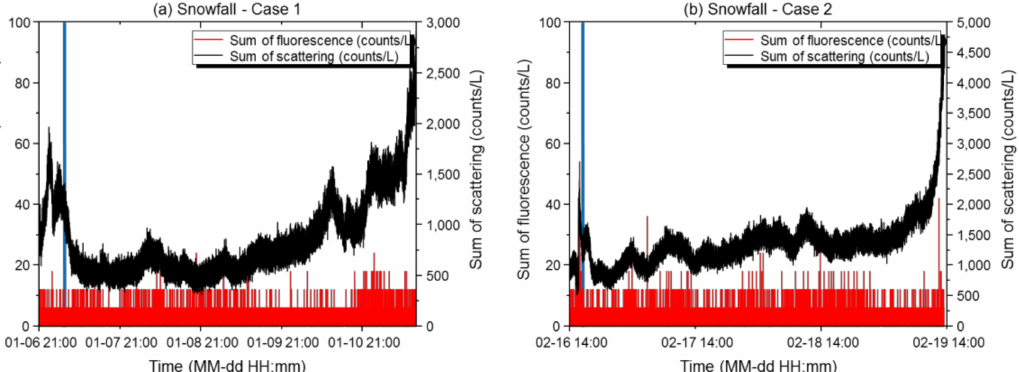
Figure 5. Results of scattered light and fluorescence measurements of the biological particle detector during snow. ( a , b ) Time-dependent concentrations of scattered light and fluorescent particles in Case 1 ( a ) and Case 2 ( b ). The X-axis represents the measurement period, and the Y-axis represents the measured particle concentrations. The black line represents the scattered light sum (counts/L), the red line represents the fluorescence sum (counts/L), and the blue line represents the time of maximum